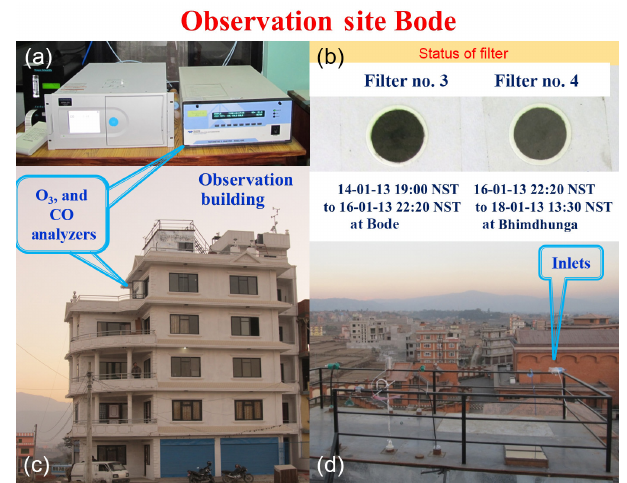
Figure 2. The observation setup with O 3 and CO analyz- ers (a) placed at the fourth floor of a building at Bode, Nepal (c) . The position of sampling inlets is towards the eastern side of the valley (d) . Almost black inlet filters are seen for 2 days of operation at the Bode and Bhimdhunga sites (b)